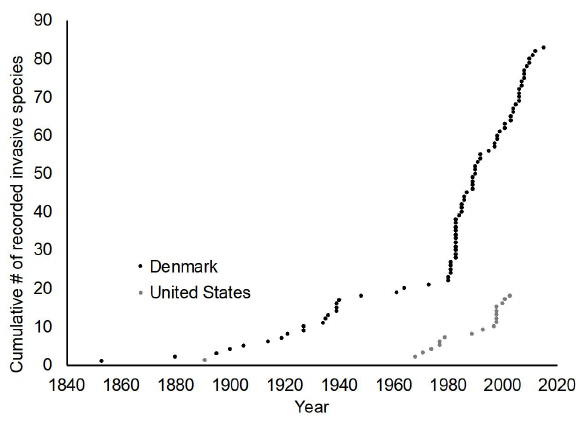
Figure 2. Cumulative number of invasive marine species reported in government documents in Denmark (black) and the United States (Alaska; gray). Standardized monitoring protocols were used in the United States (all years) and in Denmark after